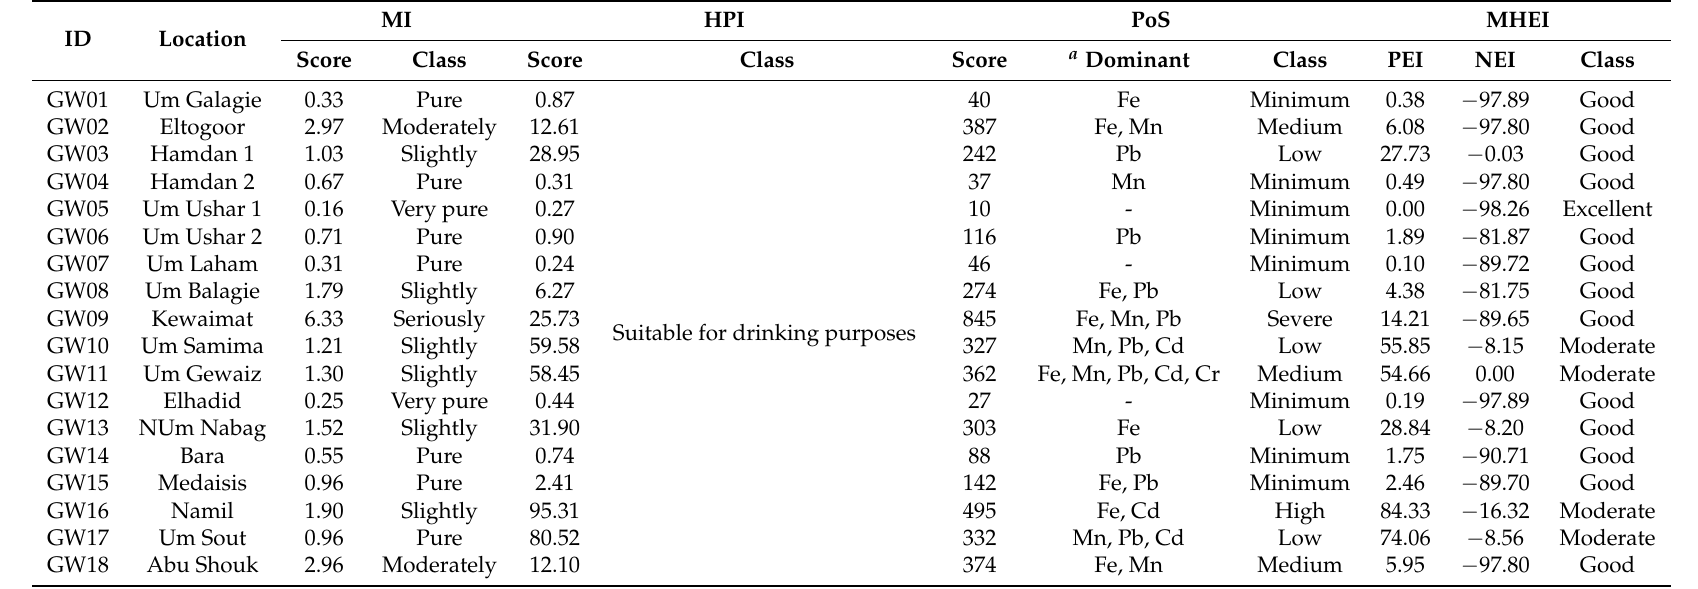
Table 8. Comparison results of water quality classification by MI, HPI, PoS, and